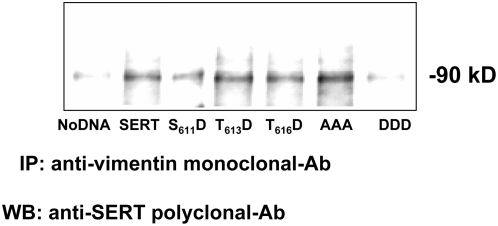
Vimentin binding ability of SITPET mutants.CHO cells expressing the indicated SERT constructs were lysed and prepared for IP. The cell lysate was incubated with anti vimentin-Ab coated protein A sepharose beads. The presence of SERT truncations was detected with a polyclonal SERT Ab (Chemicon International). Nonspecific adsorption of Sepharose beads was not determined in the absence of vimentin-Ab and the data obtained from this set of experiment is not presented here since it can be found in Figure 1B. All lanes contain protein recovered from the same number of cells equivalent to one of well from a confluent 24-well culture plate. The triple mutant AAA and two of the single mutants, T613D and T616D, bound to vimentin; S611D showed a low affinity for binding to vimentin. Figure shows representative images from 3 separate experiments.